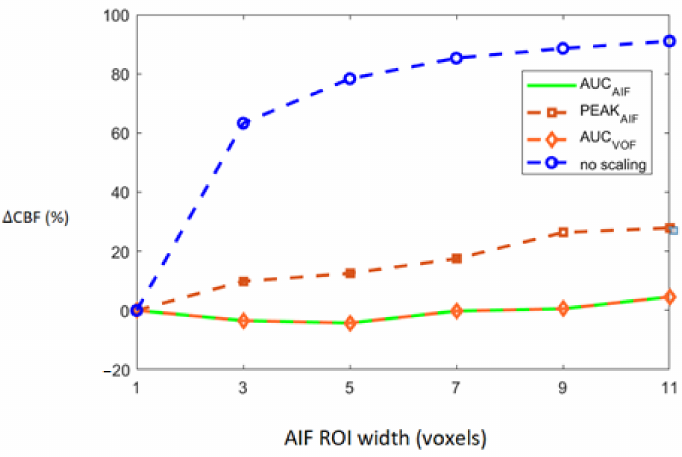
Figure 4. Average CBF divergence from reference CBF plotted against increasing number of voxels. Average CBF divergence for group of 15 patients is plotted according to increased partial volume effect (PVE) for all four scaling approaches indicated by the legend on